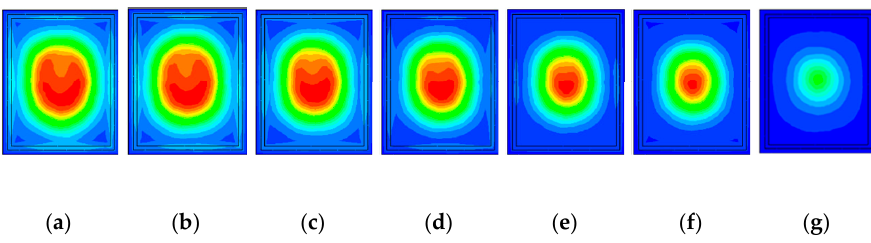
Figure 12. Temperature field of the burner exit (XY cross section) for different oil feed rates when the extension distance was 400 mm (K). ( a )1 60 kg/h, ( b ) 140 kg/h, ( c ) 120 kg/h, ( d ) 100 kg/h, ( e ) 80 kg/h, ( f ) 70 kg/h, ( g ) 60 kg/h.